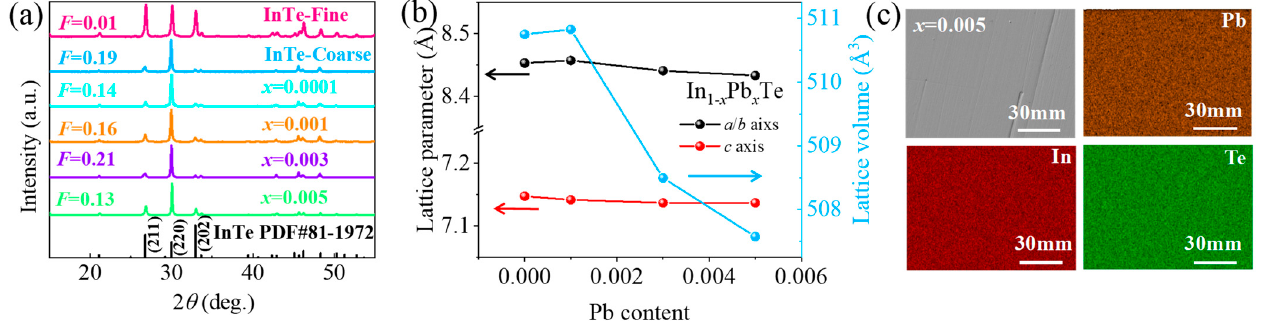
Figure 1. ( a ) The PXRD patterns of samples for the sieved coarse In 1- x Pb x Te ( x = 0, 0.0001, 0.001, 0.003, 0.005) and the sieved fine InTe. ( b ) The lattice parameter dependence on the Pb dopant concentration. ( c ) SEM image and corresponding EDS compositional mappings for the sieved coarse In 0.995 Pb 0.005 Te sample.